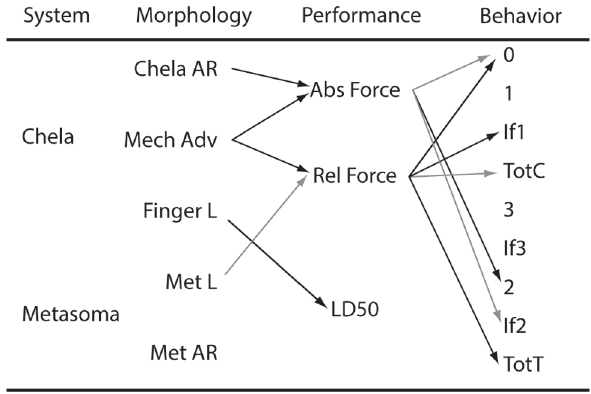
Figure 2. Schematic of the significant (black) correlations between variables. Correlations which with p-values between 0.05 and 0.1 are shown in grey. Each well-supported path between morphological, performance and behavioral variables were tested using Sobel’s test of mediation. Of the six paths tested, only the path between chela aspect ratio, maximum force and behavioral category 2 (stinger use) displayed partial mediation of the performance variable (p=0.026). Two more paths were found to show some indication of mediation (Mech.Adv - Rel. Force - IF1, p=0.088; Mech. Adv. – Rel. Force – TotT,